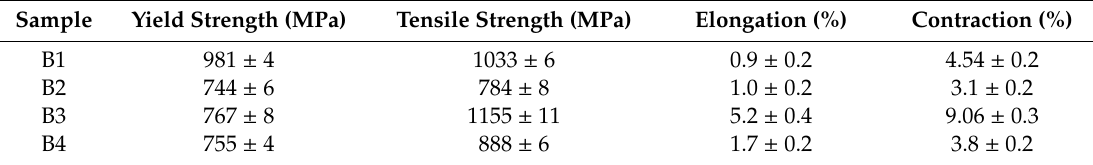
Table 6. Average mechanical properties of the clad layers.